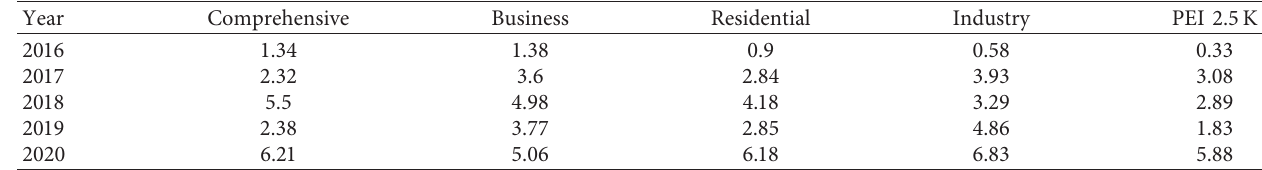
Table 9: Number of trials or attempts at learning.